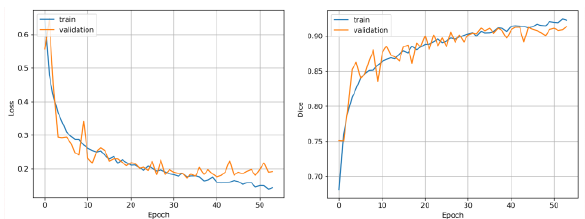
Figure 2. U-Net training history showing training and validation loss and dice